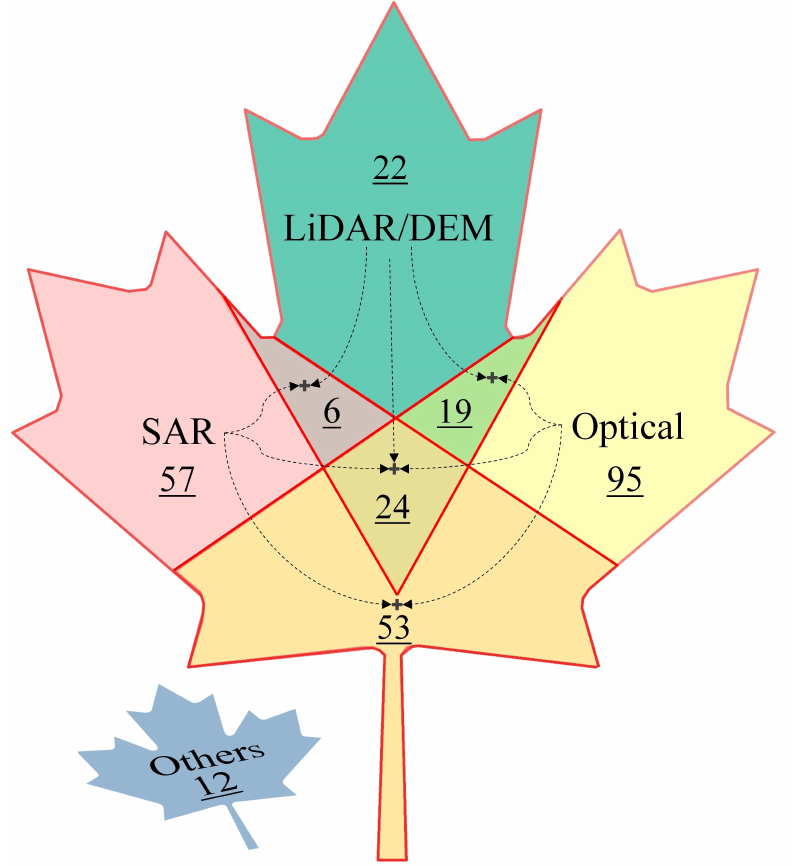
Figure 13. Data type(s) used in wetland studies in Canada.